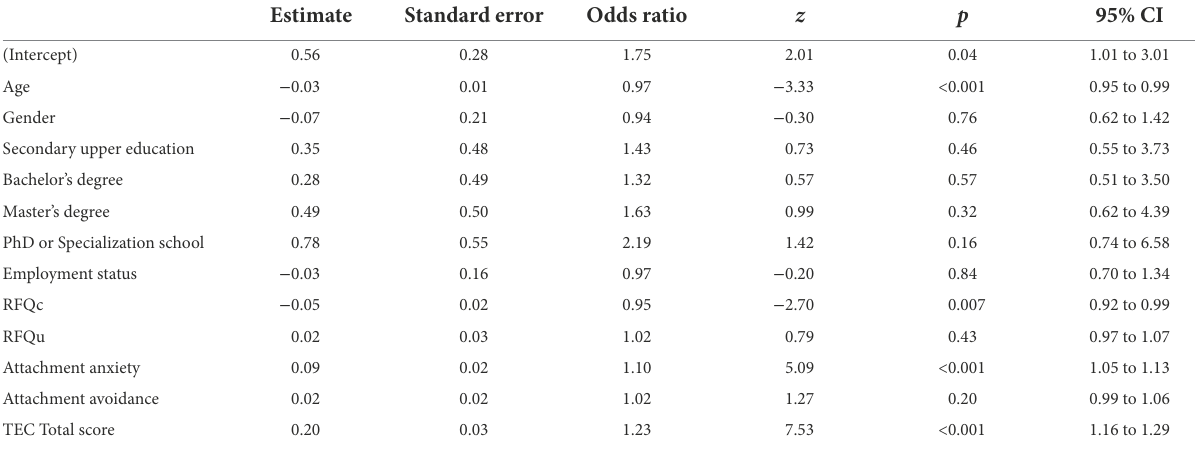
TABLE 3 Multiple logistic regression analysis with history of suicidal ideation as model